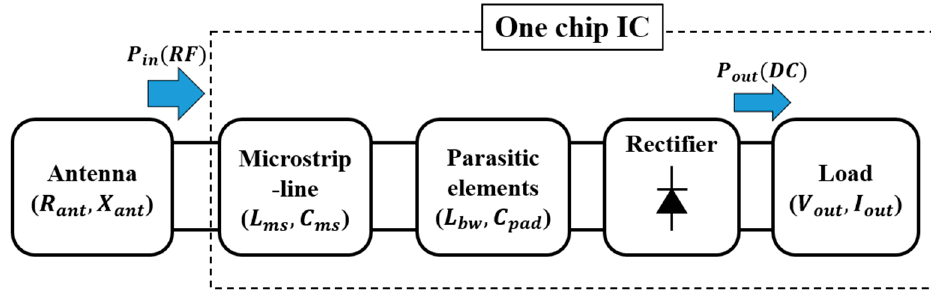
Figure 1. Block diagram of rectenna circuit for MWPT.